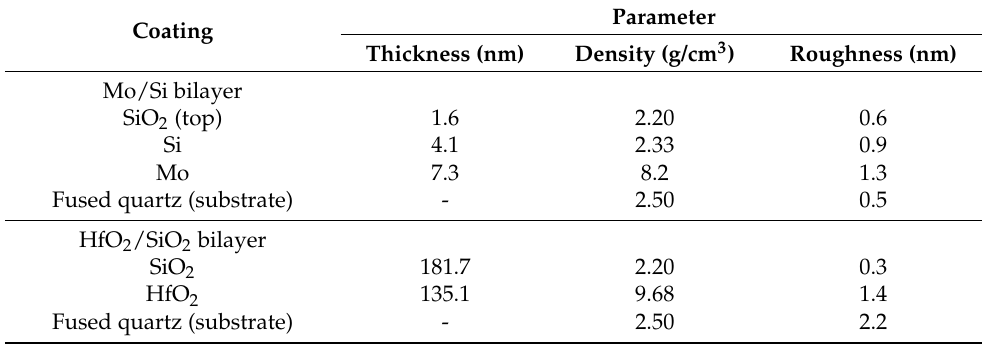
Table 4. XRR data on inner structures of some coatings (original and irradiated in air).